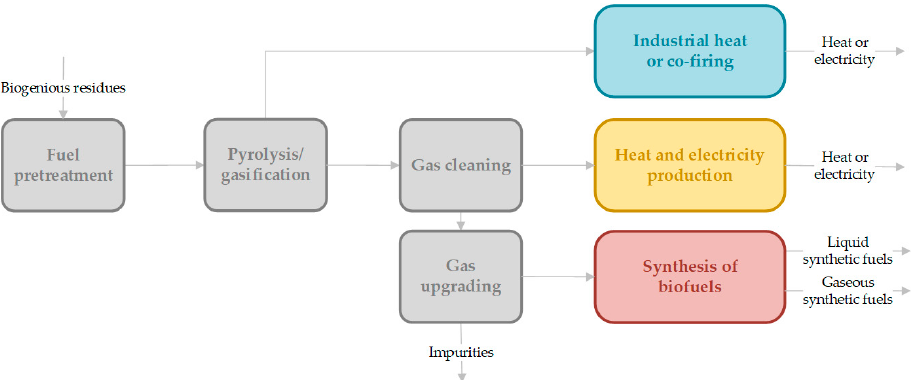
Figure 1. Process units in gasification technology for the production of energy carriers (heat or electricity) or biofuels (Fischer Tropsch products, methanol (liquid) and di ‐ methyl ‐ ether and SNG (gaseous)), inspired by [3], Hofbauer: 2012.